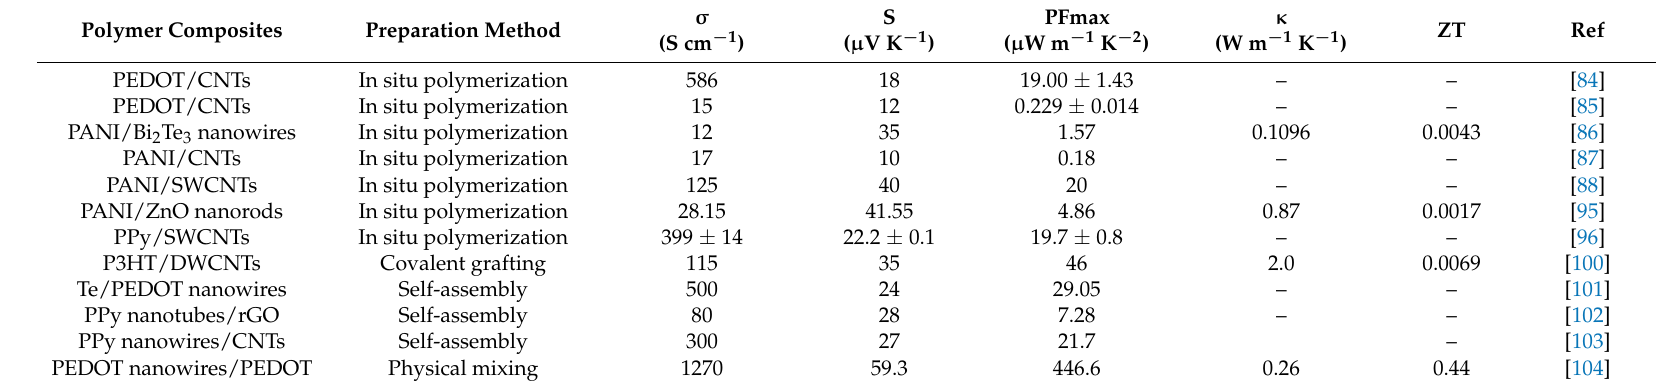
Table 2. Summary of the thermoelectric properties of 1D conducting polymer nanocomposite